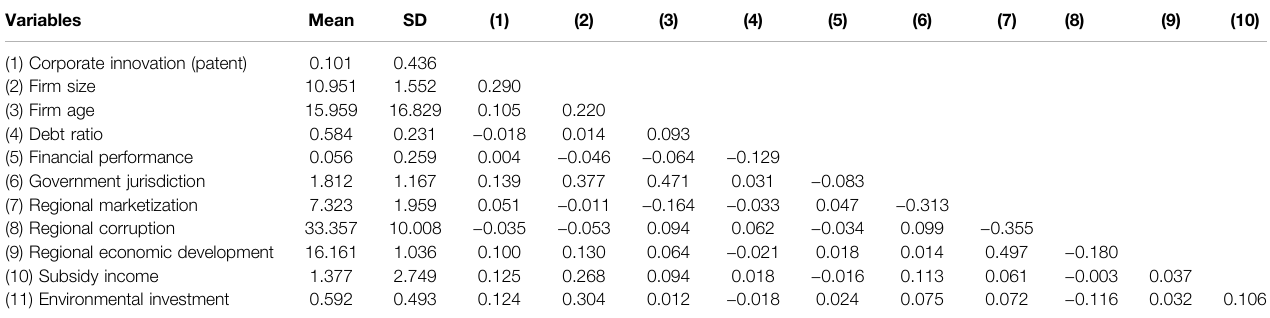
TABLE 1 | Descriptive statistics and correlation matrix. Variables